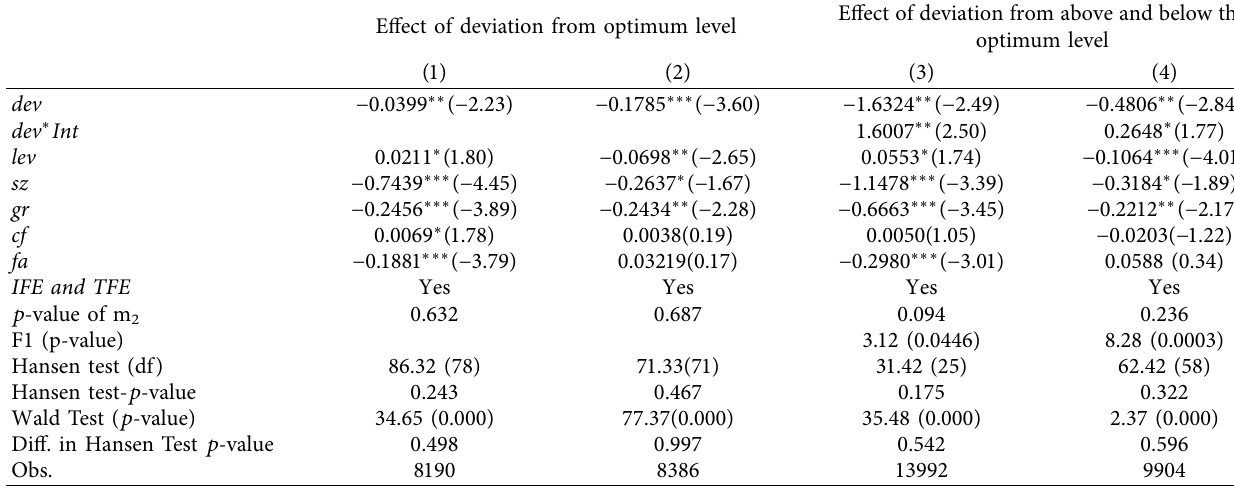
Table 4: Regression results for the effect of deviation, and deviation from above and below the optimal level of cash holding on firm